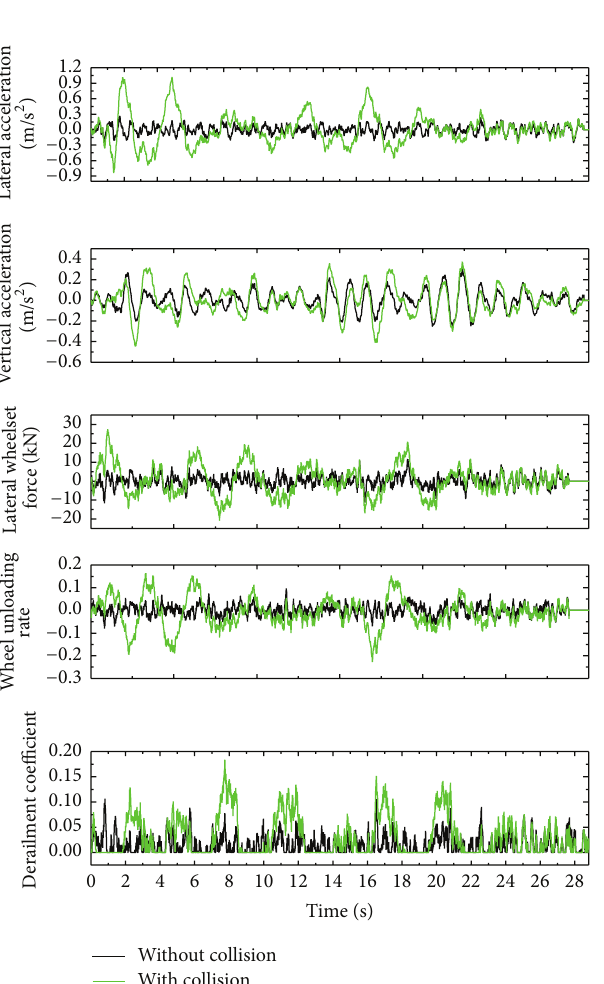
Figure 12: Responses of a single car ( 𝑋 2 = − 385 m, 80 km/h, in the down direction). Figure 13: Responses of the trailer (the first train,